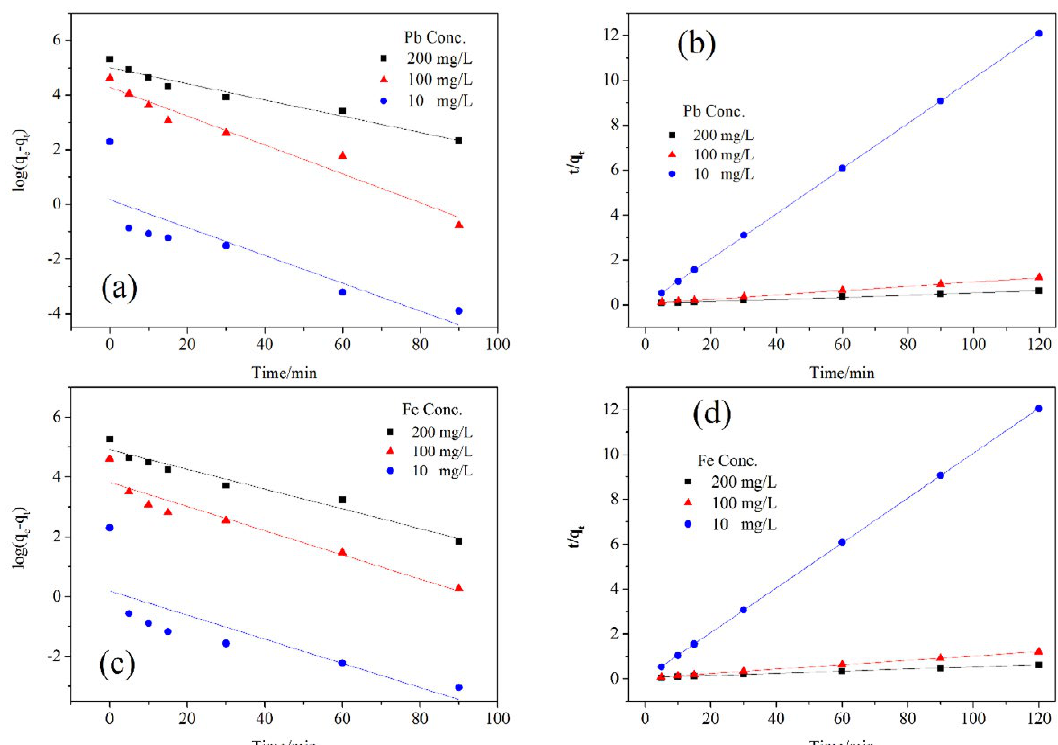
Fig. 3: The linearized pseudo-first-order kinetic (a, c) and pseudo-second-order kinetic (b, d) plots for adsorption of heavy metal ions onto CaCO 3 nanoparticles.